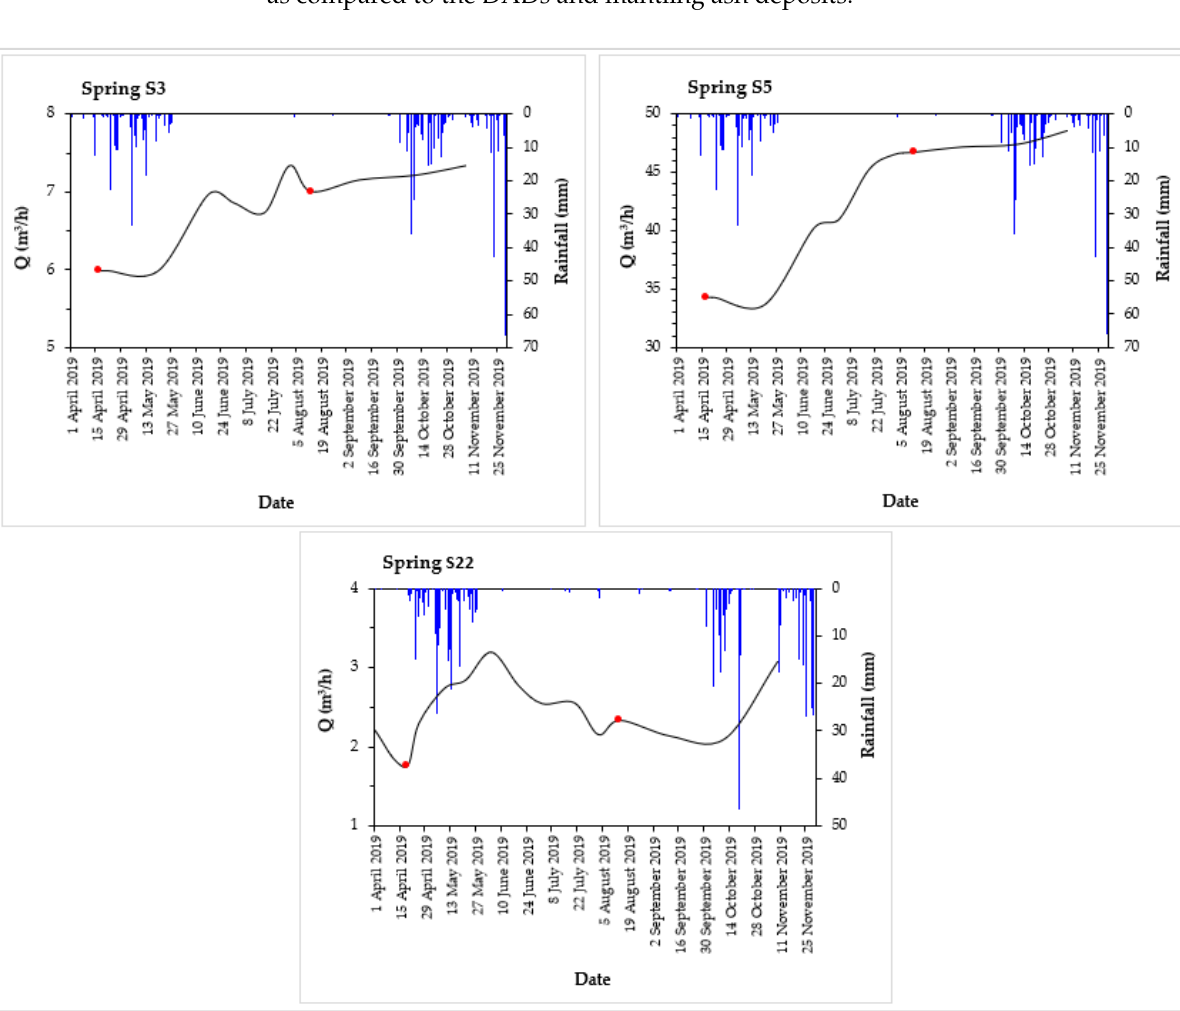
Figure 14. Spring discharge fluctuation at Oldonyo Sambu (S3 and S5) and at Ngarenanyuki (S22), and rainfall (Mamsa rain station for S3 and S5, and ASA Farm rain station for S22). Red dots indicate discharge values during water sampling.